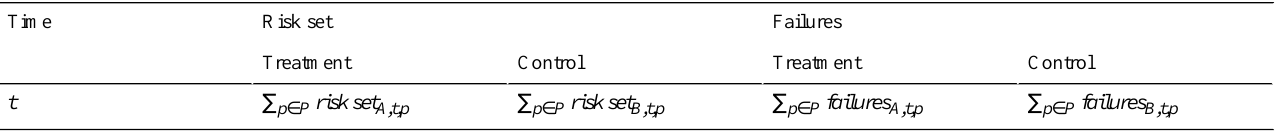
Table 1. Merged data table containing all times t from all participating stakeholders. If multiple stakeholders provided data for the same t, they were merged by